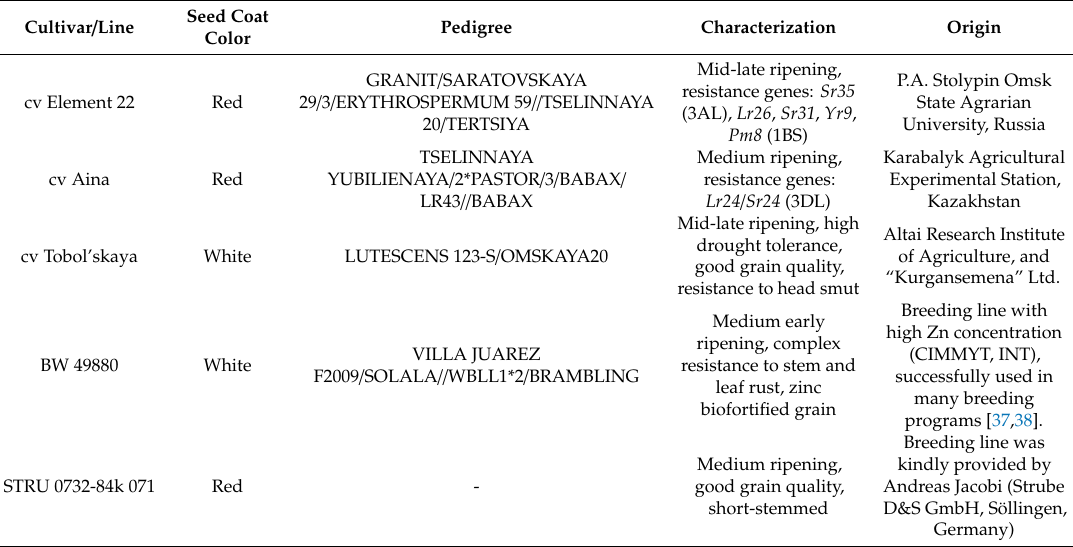
Table 1. The recurrent parental cultivars and lines of Triticum aestivum L.